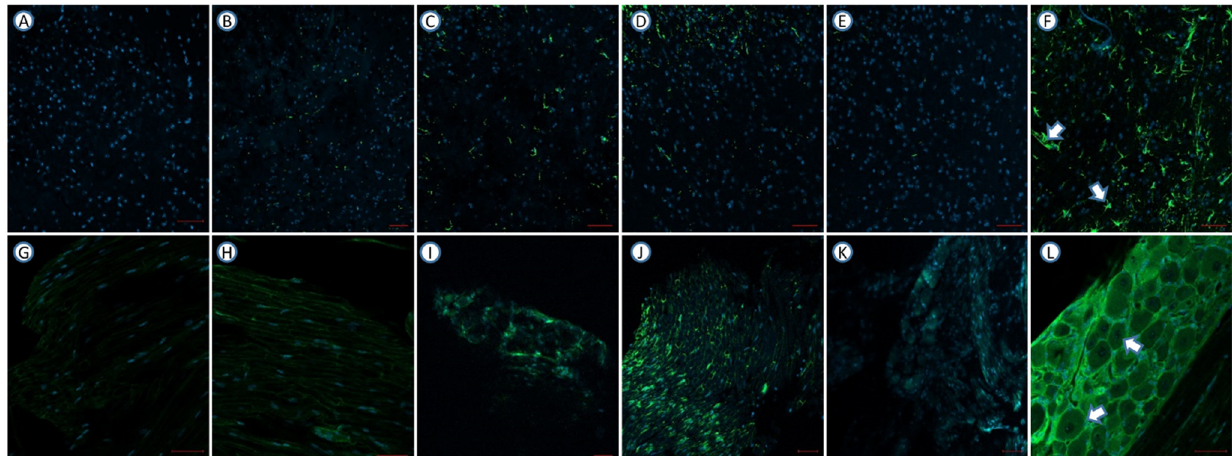
Figure 5. The effect of intraperitoneal injection of mixed drugs on the expression of GFAP (luminous green) in the spinal cord and dorsal root ganglion of the SNL model. Original magnification; ×200. ( A ) GFAP immunohistochemical staining of the spinal cord of mice in sham operation group ( n = 4). ( B ) Pre20 mg/kg + Tra10 mg/kg-injected SNL mouse ( n = 6). ( C ) Pre15 mg/kg + Dul15 mg/kg-injected SNL mouse ( n = 6). ( D ) Dul30 mg/kg + Tra10 mg/kg-injected SNL mouse ( n = 6). ( E ) Pre10 mg/kg + Dul10 mg/kg + Tra10 mg/kg-injected SNL mouse ( n = 6). ( F ) normal saline-injected SNL mouse ( n = 4). ( G ) GFAP immunohistochemical staining of the DRG of mice in sham operation group ( n = 4). ( H ) Pre20 mg/kg + Tra10 mg/kg-injected SNL mouse ( n = 6). ( I ) Pre15 mg/kg + Dul15 mg/kg-injected SNL mouse ( n = 6). ( J ) Dul30 mg/kg + Tra10 mg/kg-injected SNL mouse ( n = 6). ( K ) Pre10 mg/kg + Dul10 mg + Tra10 mg/kg-injected SNL mouse ( n = 6). ( L ) normal saline-injected SNL mouse ( n = 4). GFAP, glial fibrillary acidic protein; DRG, dorsal root ganglia; SNL, spinal nerve ligation; Pre, pregabalin; Dul, duloxetine; Tra, tramadol.